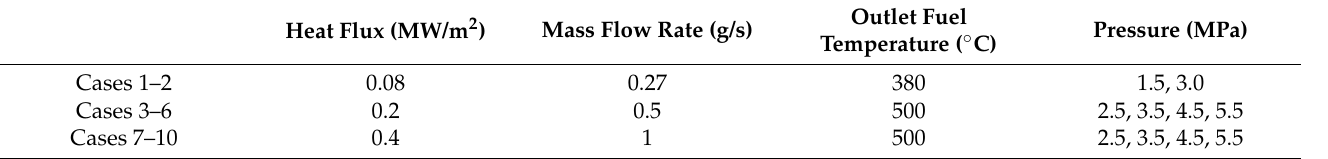
Table 1. Three different heat fluxes were employed in this experiment to match real-world